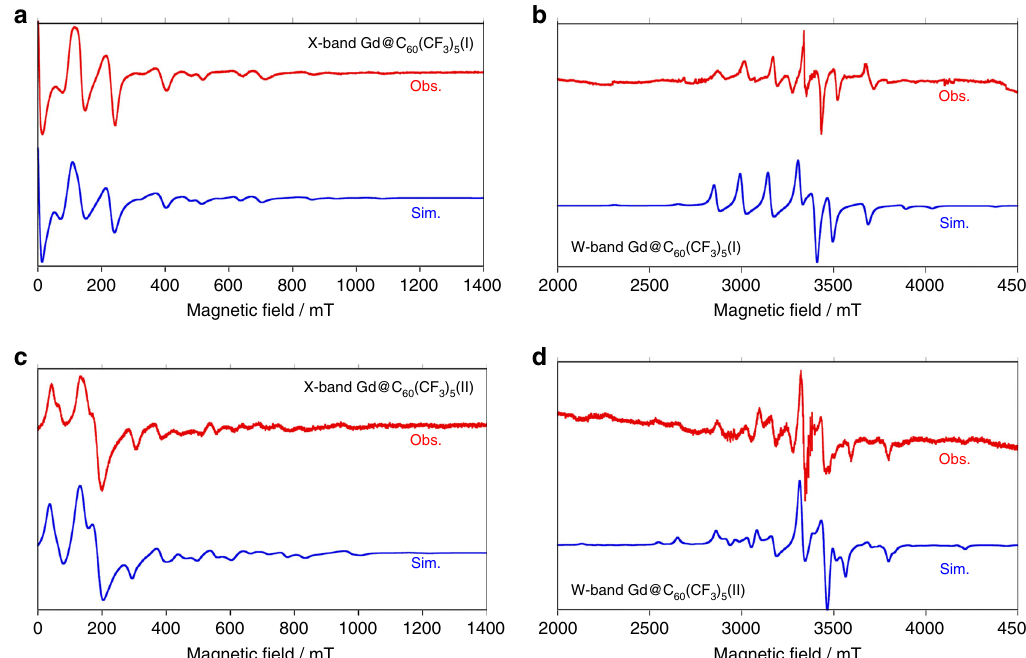
Fig. 4 Con fi rmation of ESR parameters for Gd@C 60 (CF 3 ) 5 (I) and Gd@C 60 (CF 3 ) 5 (II). a , c ESR spectra (red lines) of Gd@C 60 (CF 3 ) 5 (I) and Gd@C 60 (CF 3 ) 5 (II) recorded by X-band (9 GHz) spectrometer in CS 2 at 4 K, b , d W-band (90 GHz) spectrometer in CS 2 at 20 K. ESR parameters were determined so that both observed spectra in a – d should be simultaneously reproduced by simulation (blue